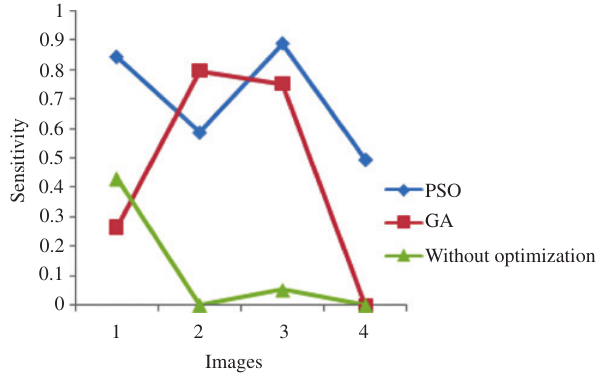
Figure 8: Sensitivity Graph for Three Optimization Algorithms.